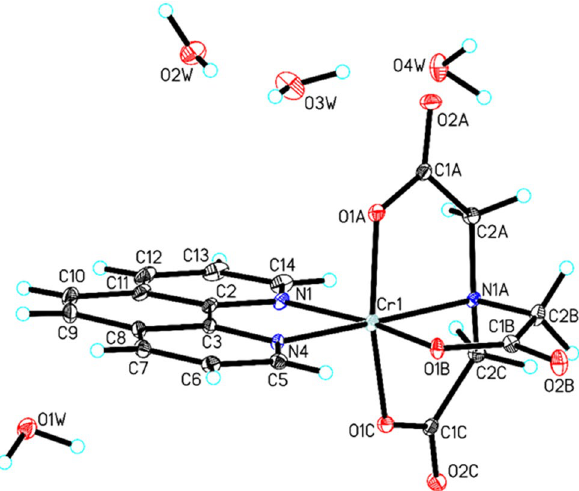
Figure 1. Molecular structure of title compound, showing the atom-labelling scheme (hydrogen bonds are represented by dashed